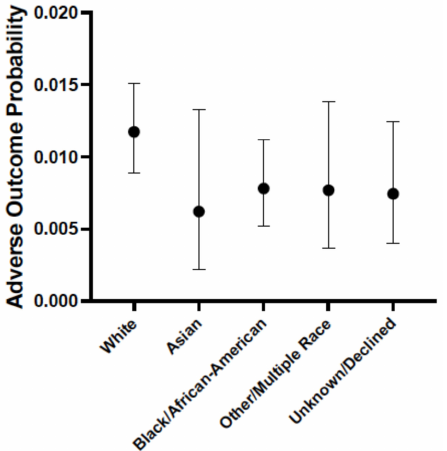
Figure 3. Race-only model for simvastatin adverse events. Shown is the probability of experiencing any adverse outcome while taking simvastatin based on race only. All comparisons used the White group as the reference. Logistic regression model for any simvastatin adverse drug reactions relative to White/European-American patients #